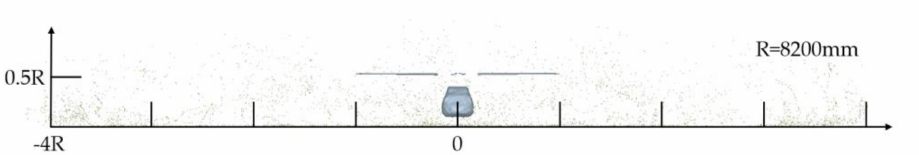
Figure 9. Dust distribution at 2 s.